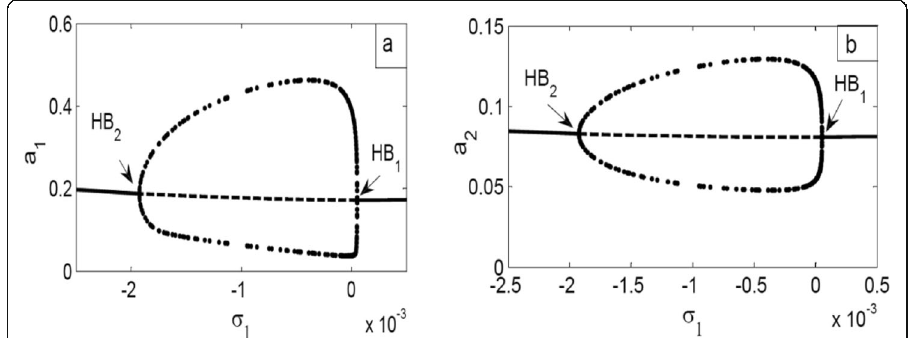
Fig. 12 Bifurcation diagram of detuning parameter σ 1 as the bifurcation